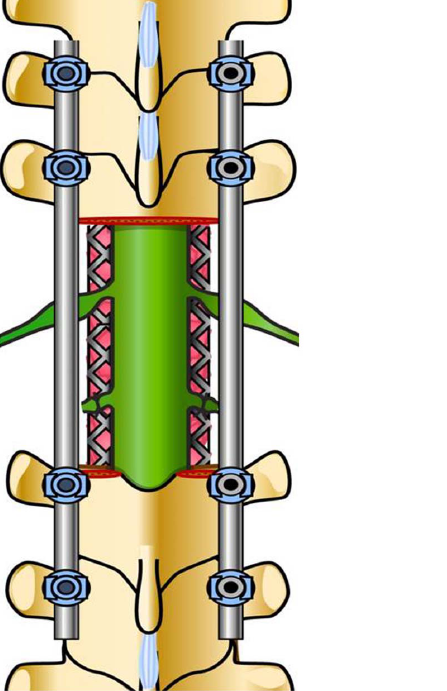
Figure 1. A schema of upper thoracic total en bloc spondy- lectomy; the T1 nerve roots are circumferentially dissected to the extraforamen and the T2 nerve roots are transected.